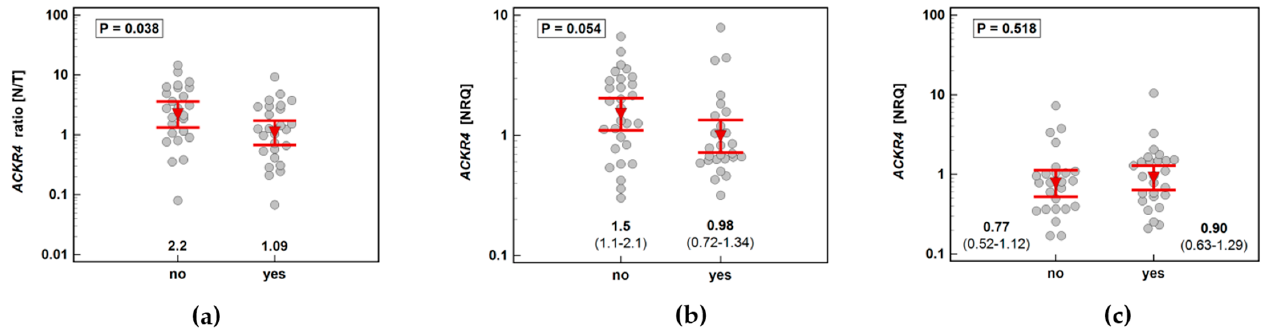
Figure 7. Impact of lymph node involvement on ACKR4 expression: ( a ) normal–to-tumor expression ratio (N/T); ( b ) in macroscopically normal tissue; ( c ) in tumors. Data presented as dot-plots with means with 95% confidence interval (figures below the dot-plots and red triangles with whiskers) and analyzed using t -test for independent samples. NRQ, normalized relative quantity.